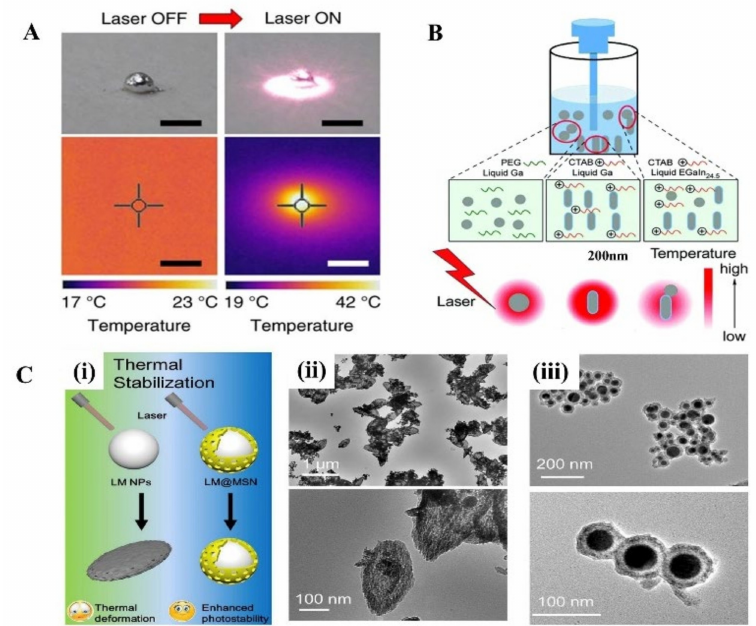
Figure 3. The photothermal effect of LMMMs. ( A ) Visible light and thermographic images of a LM droplet (1mg) before and after irradiation with a 785nm NIR laser at 1 W for 5 min. Scale bars, 2 mm [69]. ( B ) Schematic illustration of the photothermal effects of three different kinds of LM nanomaterials [31]. ( C ) ( i ) The scheme of morphology changes of LM and LM@MSN after 808 nm laser irradiation. Representative TEM images of LMNPS ( ii ) and LMNPs@MSN ( iii ) after 808 nm laser irradiation (1 W/cm 2 ) for 10 min